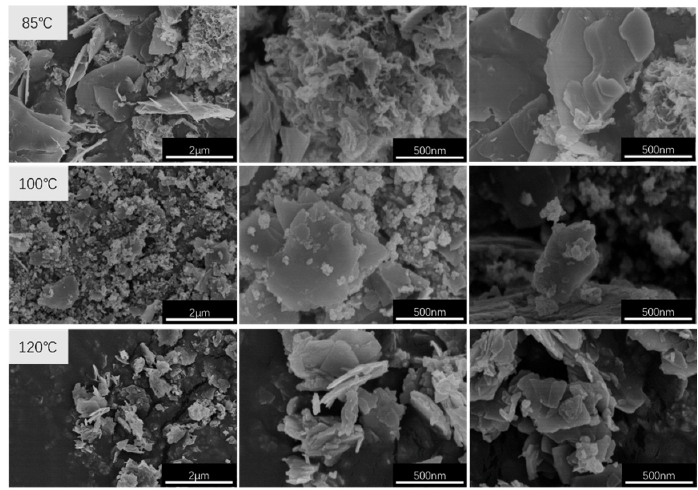
Figure 4. SEM images of CaAl–SiO 3 –LDHs samples prepared at different crystallisation